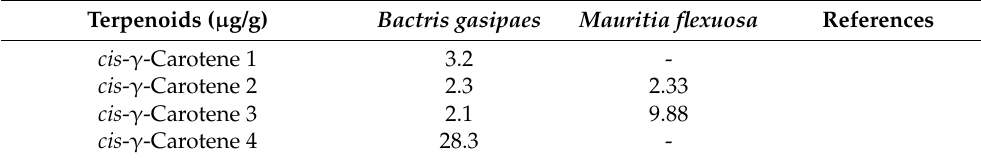
Table 2. Specialized compounds in peach palm